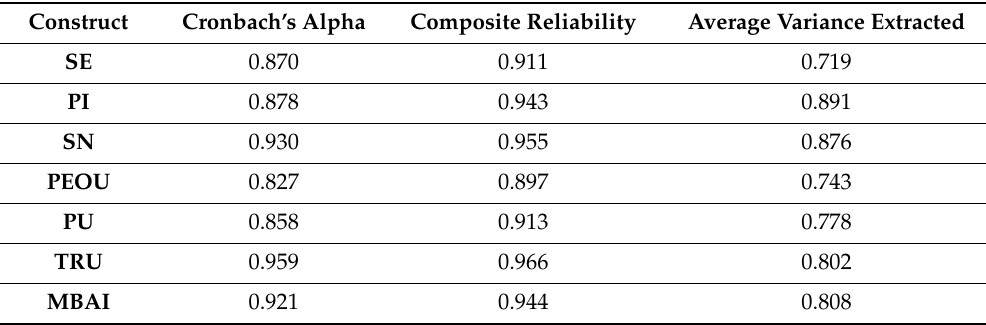
Table 5. Discriminant Validity.